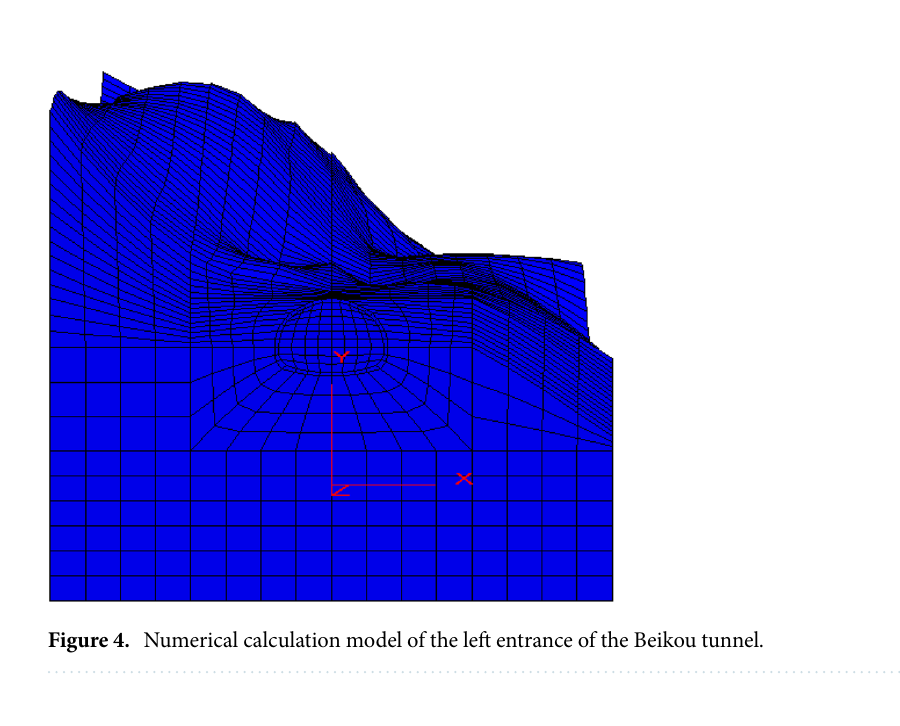
Table 1. BQ classification results of the surrounding rock of the Beikou tunnel.